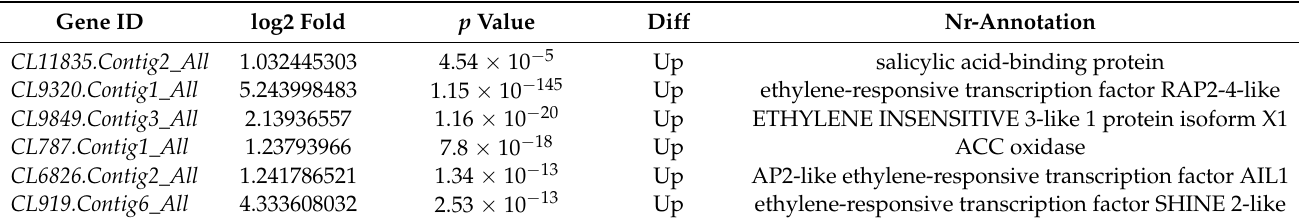
Figure 7. Relative expression of genes related to plant hormones. Data is presented as the mean ± standard deviation (n = 9). Student’s t test: ** p ≤ 0.01. Table 2. Genes related to ethylene